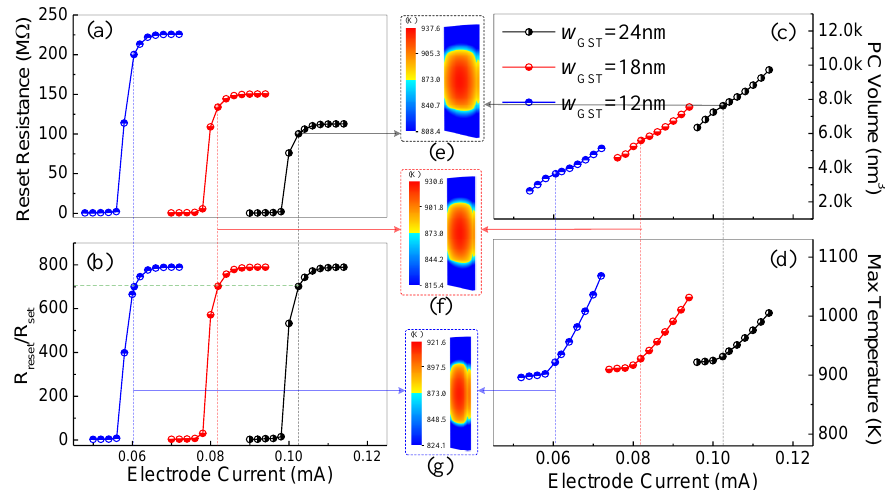
Figure 9. ( a ) Reset resistance, ( b ) resistance ratio, ( c ) phase change volume, and ( d ) maximum temperature values of cells with different 𝑤 ch . ( e – g ) The temperature distributions of 3-D GST strips at 𝑡 = 1.8 ns . Table 2. Simulated results of the PCM cells with different 𝑤 GST and ℎ GST values.